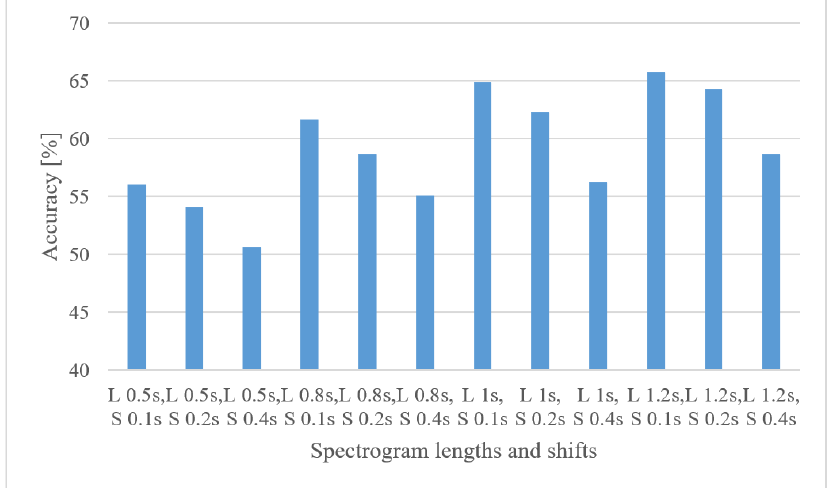
Figure 4. Averaged accuracies for spectrogram lengths (L) of 0.5, 0.8, 1, 1.2 s and 0.1, 0.2, 0.4 s shifts (S) between adjacent intervals.